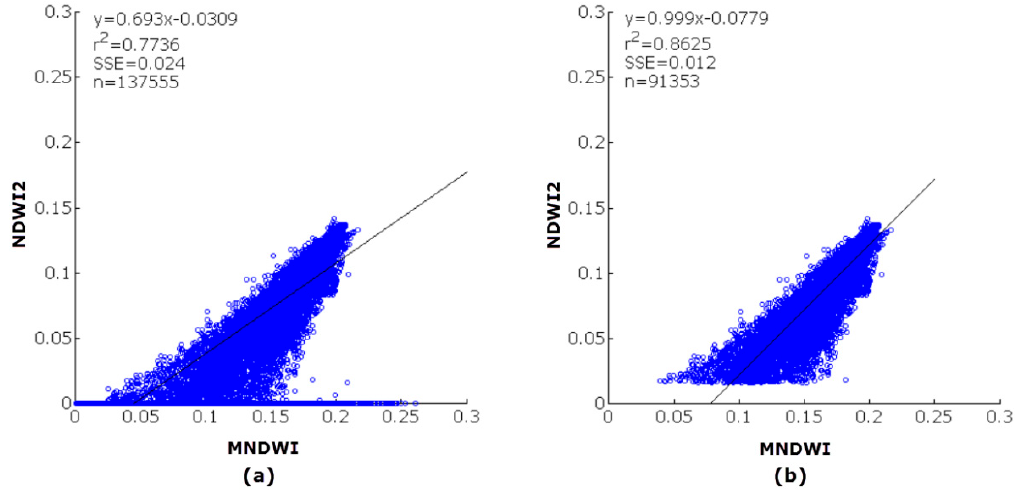
Figure 4. The scatter plots showing the correlation between MNDWI and NDWI2 when using: ( a ) the typical zero threshold; and ( b ) the optimal threshold, which are MNDWI > 0.032 and NDWI2 > 0.016.